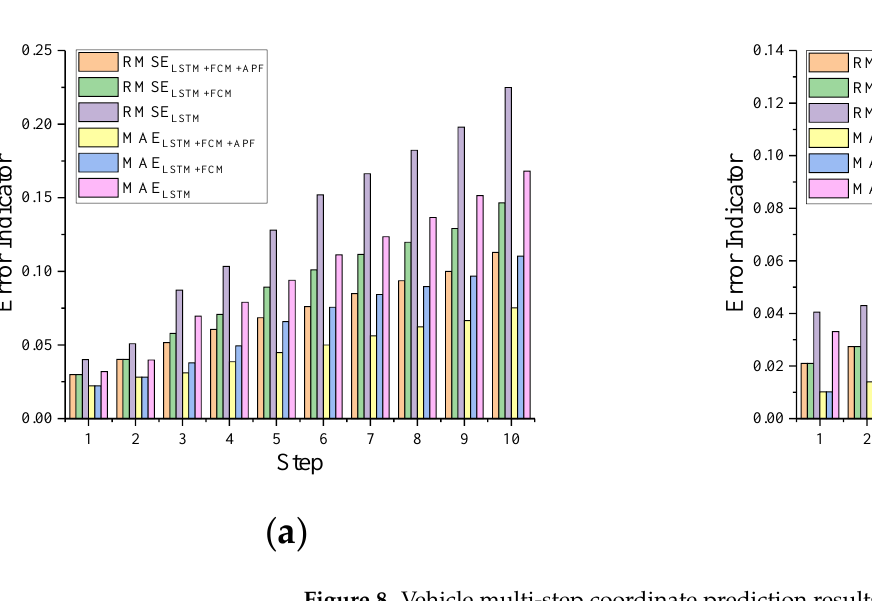
Figure 8. Vehicle multi-step coordinate prediction results: ( a ) multi-step prediction results for the lateral coordinate of vehicle 1 and ( b ) multi-step prediction results for the longitudinal coordinate of vehicle 1.